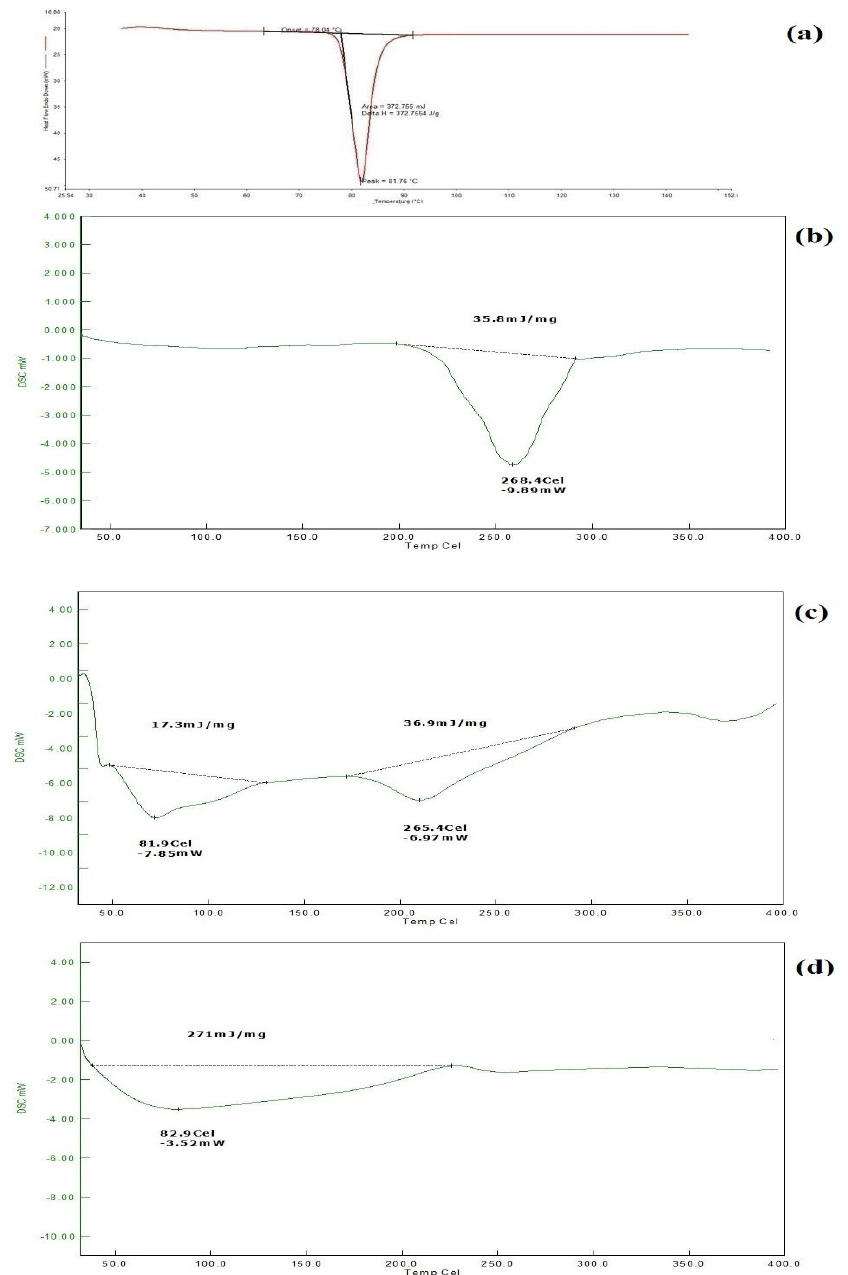
FIGURE 3 - Differential scanning colorimeter thermograms of a) RT b) carrier c) conventional direct compression physical mixture d) optimized F12 liquisolid